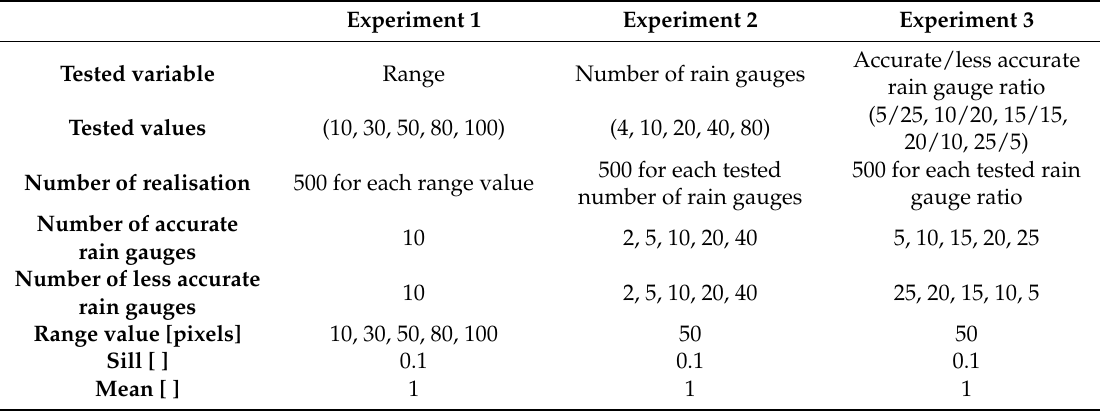
Table 2. Overview of the three experimental